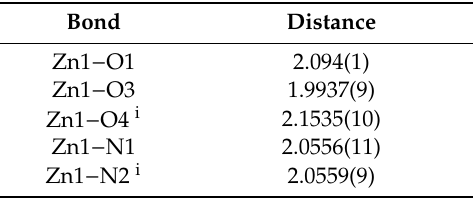
Table 4. Bond lengths to the Zn(II) ion (Å) for ( 4